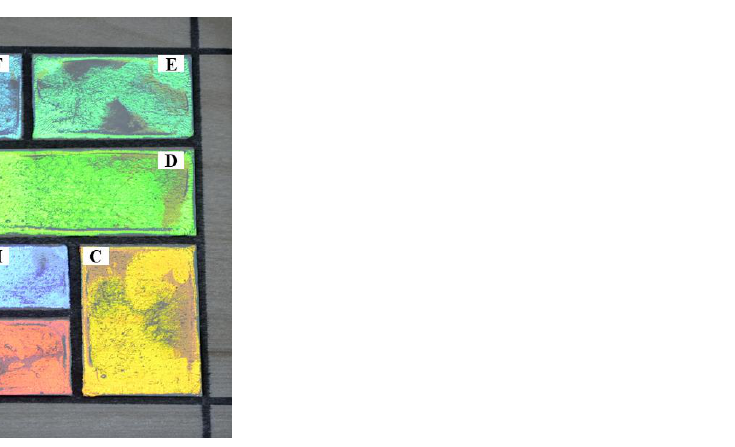
Figure 16. Patterned application of self-assembled rainbow structural color coatings on a wood surface by PSt microspheres: ( A ) magenta; ( B ) orange; ( C ) yellow; ( D ) green; ( E ) cyan; ( F ) blue; ( G ) violet; ( H ) violet.